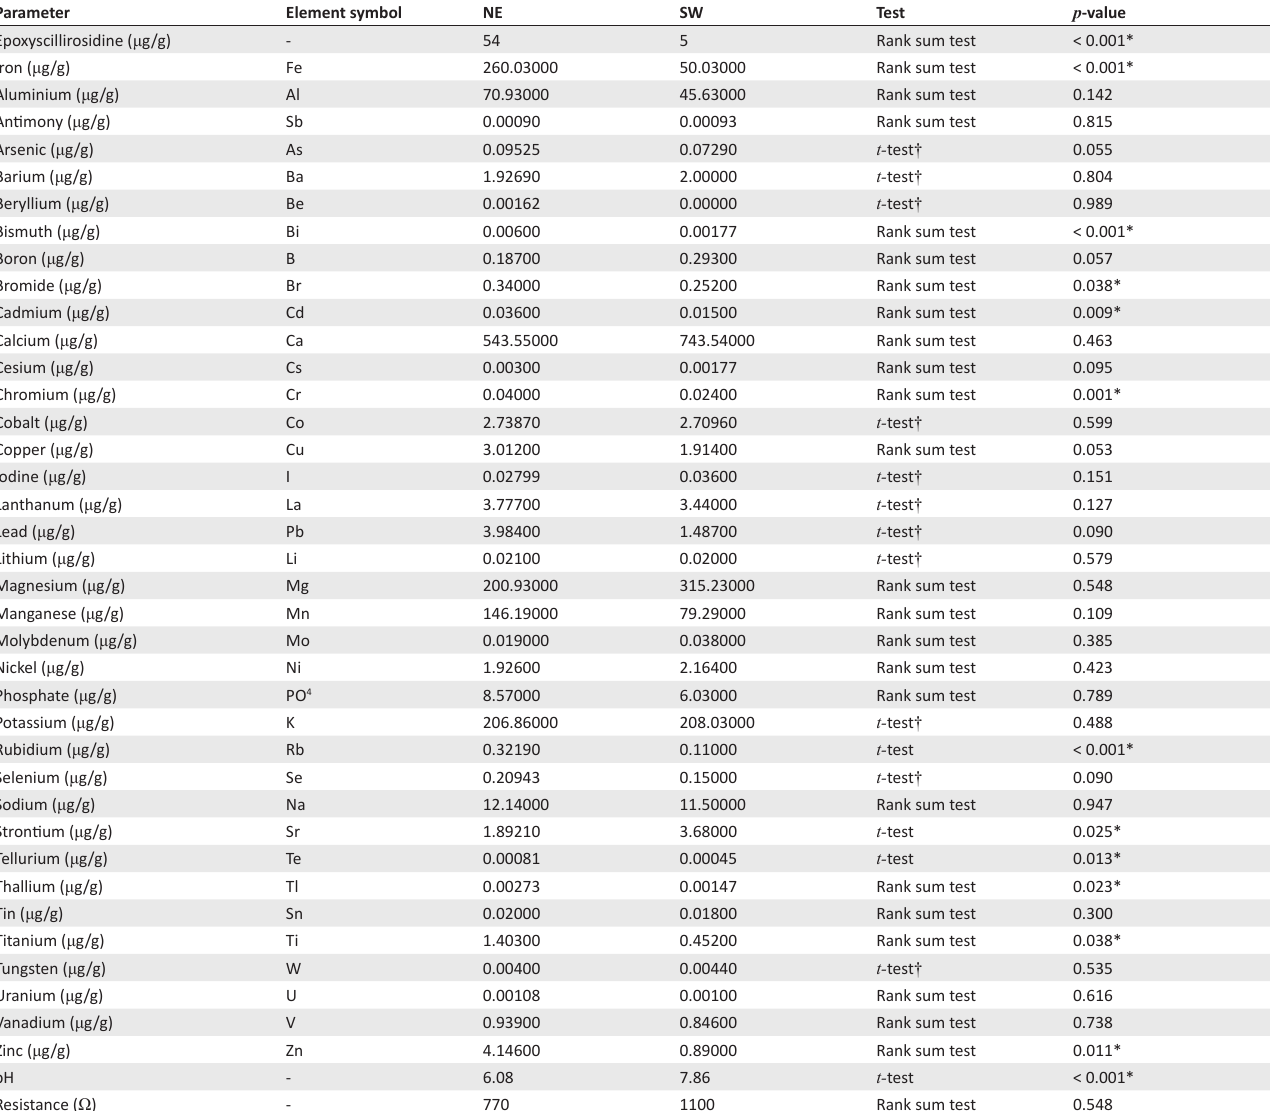
TABLE 2: Median epoxyscillirosidine concentrations in plants and median soil parameter values, to the north-east and south-west of a diagonal divisional line drawn between -26 ° N, 24 ° E and -30 ° N, 29 ° E.